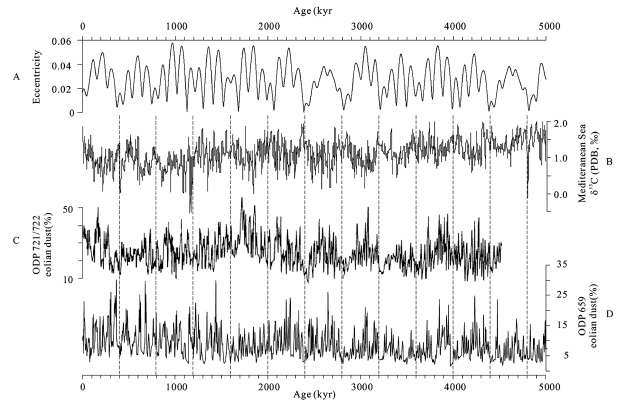
Figure 6. Long-eccentricity cycles and the GM over the last 5Ma. (a) Eccentricity cycles (100 and 400ka); (b) Planktonic δ 13 C from the Rossello composite section, Sicily, and ODP 964, Mediter- ranean Sea (after Lourens, 1994); (c) eolian dust % in ODP 721/722 (16 ◦ 38 (cid:48) N, 59 ◦ 50 (cid:48) E), Arabian Sea (DeMenocal, 1995); (d) dust flux (gm − 2 a − 1 ) at ODP 659 (18 ◦ 05 (cid:48) N, 21 ◦ 02 (cid:48) W), eastern equatorial Atlantic off Africa (Tiedemann et al.,